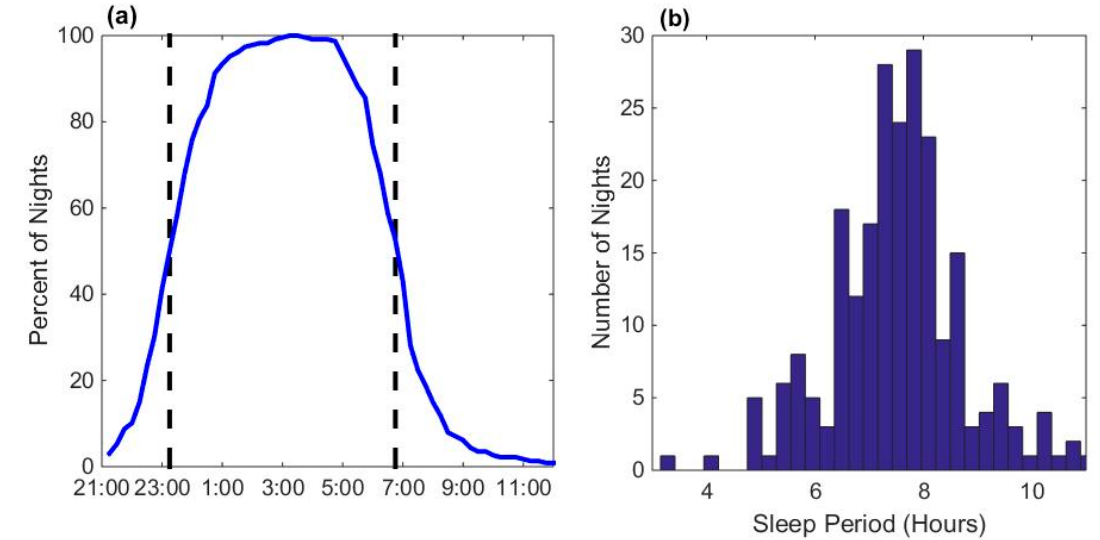
Figure 6. ( a ) Percentage of sleeping participants; ( b ) distribution of sleep period durations for all nights ( N = 227 nights).